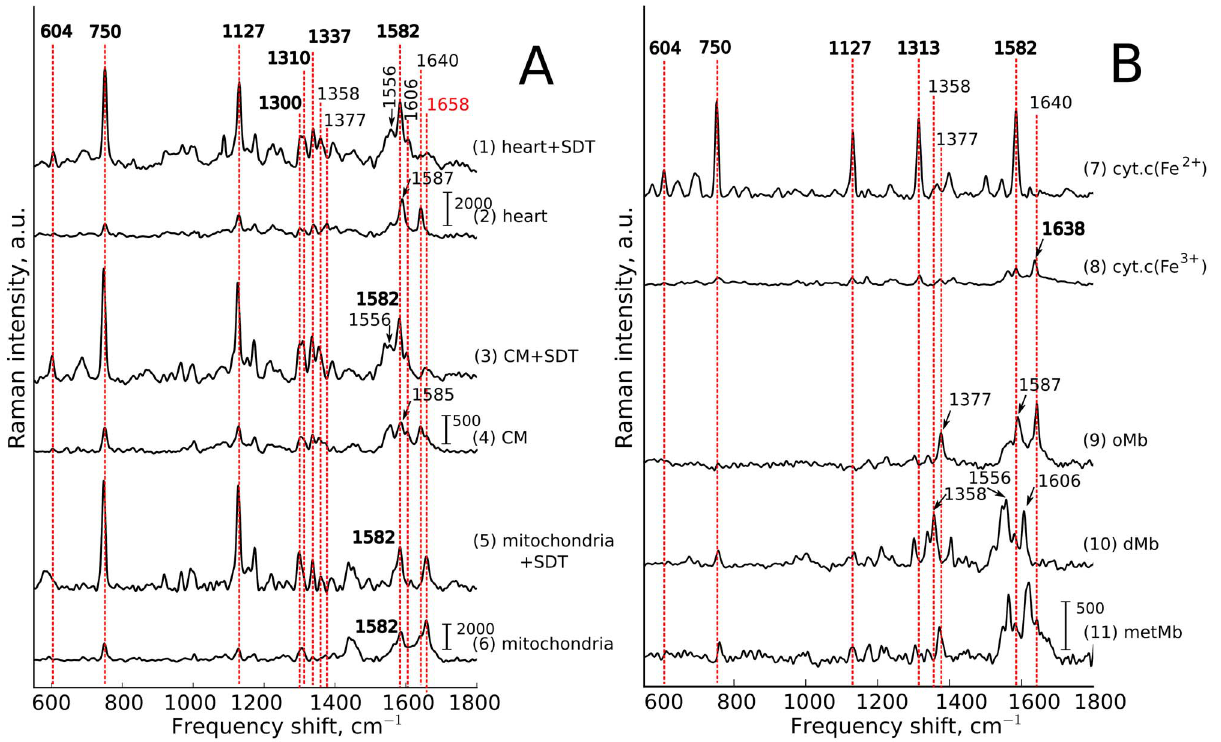
Figure 2. Peak assignment. (A): Assignment of peaks in Raman spectra of perfused heart, cardiomyocytes (CMs) and isolated CM mitochondria in partially oxidized state and after reduction with sodium dithionite (SDT). (B): Assignment of peaks in Raman spectra of reduced (cyt.c(Fe 2 + )) and oxidized (cyt.c(Fe 3 + )) cytochrome c , oxymyoglobin (oMb), deoxymyoglobin (dMb) and metmyoglobin (metMb). Vertical scale bars show Raman intensity, a.u. In Fig. 2.A vertical scale bars are the same (2000 a.u.) for heart and mitochondria with and without SDT and the scale bar is equal to 500 a.u. for cardiomyocytes with and without SDT. In Fig. 2.B scale bar (2000 a.u.) is the same for all spectra. Numbers above red dashed lines indicate peak positions, cm 2 1 . Arrows with numbers show position of peaks that are shifted relatively to the dashed line. Numbers indicating positions of peaks corresponding to cytochromes c , c1 and b are shown in bold font, to myoglobin (oMb and dMb) are shown in regular font. Peak with position at 1658 cm 2 1 (shown in red-colored font) corresponds to C ~ O bond vibration in peptide backbones of protein a -helixes.